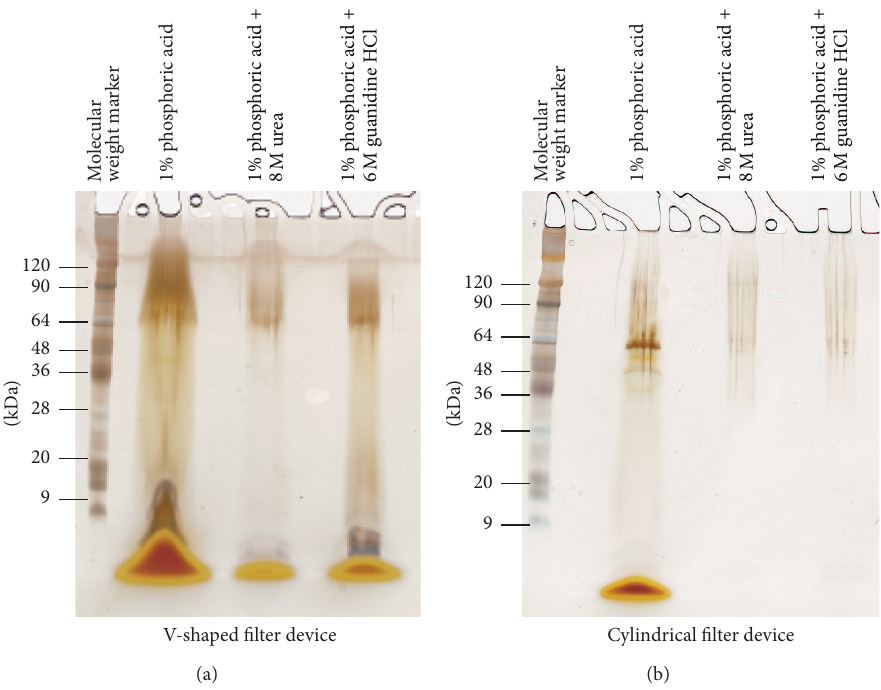
Figure 3: SDS-PAGE of protein contaminants in carmine (Sample A, cochineal extract, Biocon) after silver staining. (a) Amicon Ultra-0.5 ultrafiltration device. (b) Nanosep 3 K Omega ultrafiltration